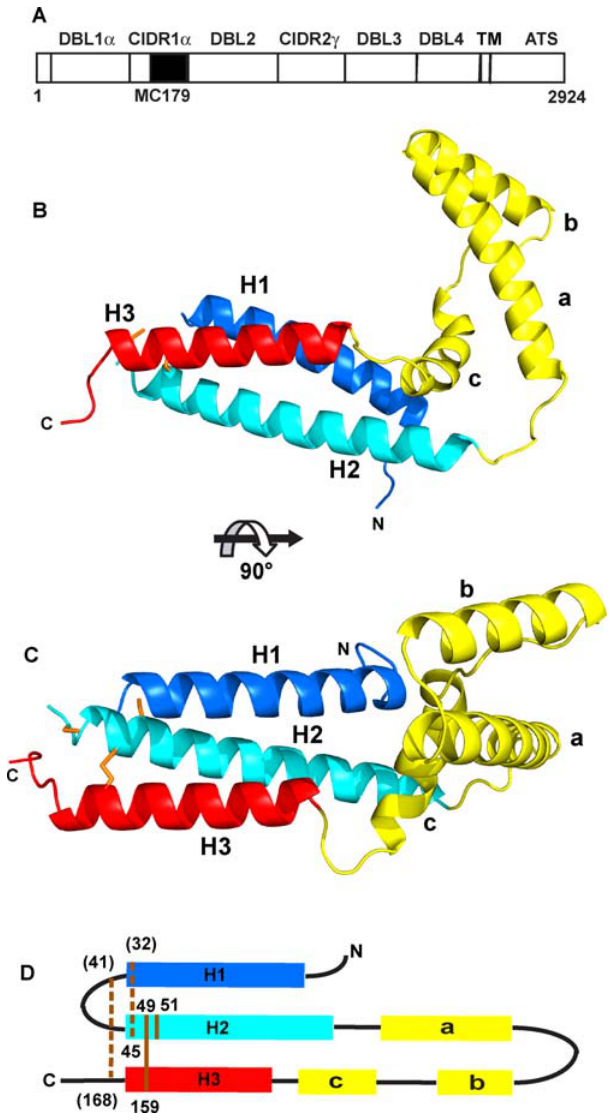
Figure 1. The MC179 structure and PfEMP1. (A) Two CIDR and four DBL domains compose the extracellular portion of the 2924-amino acid residue PfEMP1 molecule from the Malayan Camp (MC) strain of P. falciparum that is expressed on the surface of an infected red blood cell. MC179 (black box) is about 65% of the MC CIDR1 a domain. Like most PfEMP1 molecules, the MC PfEMP1 has a semi-conserved N-terminal DBL1 a -CIDR1 a pair or ‘‘head structure’’ [7]. The transmembrane (TM) segment and acidic terminal segment (ATS) are located inside the infected red blood cell. (B) The MC179 structure is made up of three helices (H1, dark blue; H2, light blue; H3, red) that form a three-helix bundle and three additional helices ( a , b , c ; yellow) that connect H2 to H3. (C) View of MC179 after reorienting by 90 u . Cysteine side chains are shown in orange. (D) MC179 topology diagram shows how the six helices are connected. Lines (orange) and residue numbers identify the positions of the three disulfide bonds and one unbonded cysteine. Two disulfide bonds were inferred to be present (dashed lines). Three cysteines (parentheses) were not observed in electron density. N- and C-termini (N, C) are